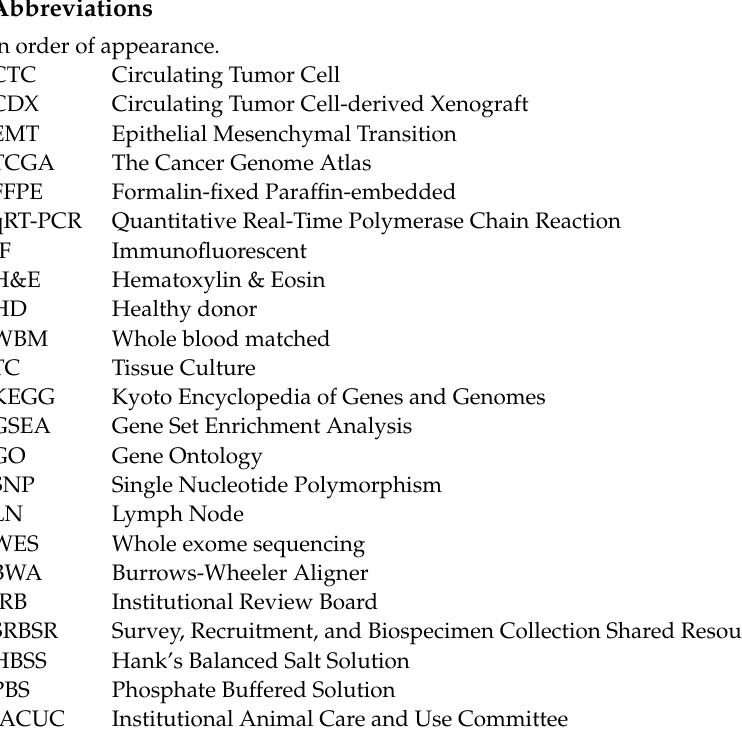
tumor-exclusive in patient #26. Table S10: Table of cancer-associated genes with mutations that were exclusive to their respective organs in the CDX models. LN = lymph node. Table S11: PCR primers used in this